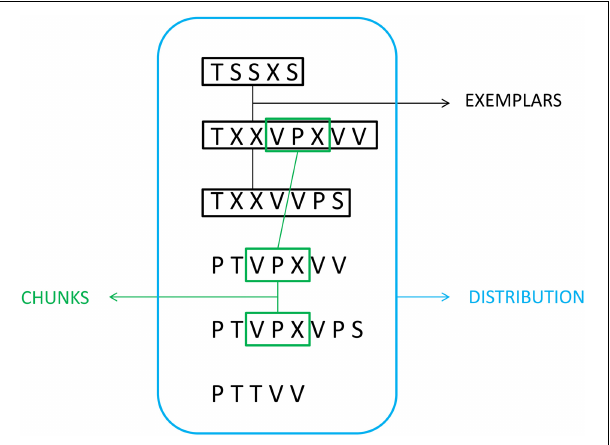
FIGURE 1 |Three types of concrete feature representations involved in encoding a sequence of letter strings generated from an artificial grammar (see “Artificial Grammar and Natural Language Paradigms” section): fragment-based or chunk information, exemplars, and distributional information (modified with permission from Cleeremans etal.,